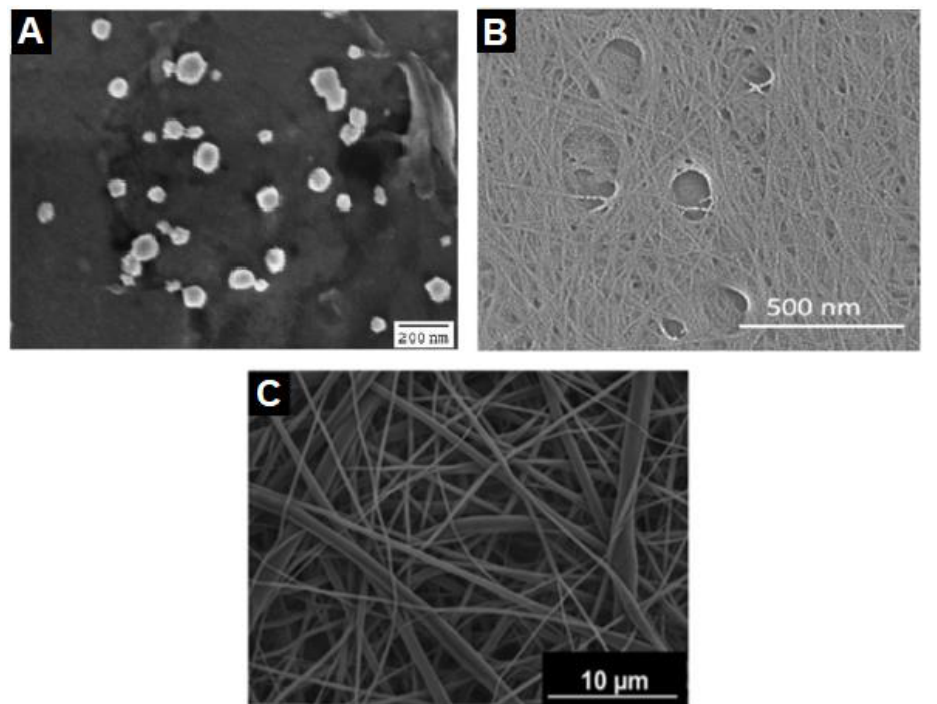
Figure 2. ( A ) SEM image of amorphous nanocellulose. Reproduced with permission from [54], [Carbohydrate Polymers]; published by [Elsevier, 2007]. ( B ) SEM image of cellulose nanoplatelets. Reproduced with permission from [55], [Carbohydrate Polymers]; published by [Elsevier, 2018]. ( C ) Top-down SEM image of electrospun cellulose nanofiber. Reproduced with permission from [57], [Carbohydrate Polymers]; published by [Elsevier, 2019]. Researchers have been encouraged to implement the use of nanocellulose for non- toxic applications due to its extensive physical, chemical, and biological properties. Due to their nanosize, they possess unique characteristics, including high mechanical strength, high surface area, surface chemical reactivity, barrier properties, renewability, biodegra- dability, biocompatibility, and non-toxicity [58,59]. As nanocellulose is known as a bio- based polymeric material equipped with unique properties and biocompatibility and re- newability, it can be used in a variety of ways in many eco-friendly fields, especially in the food, cosmetics, and pharmaceutical industries. In the food industry, it has been used as food additives and in food packaging materials [60]. In addition to this, its low cytotox- icity and high biocompatibility have attracted much attention in the biomedical field, where it has been employed in health care applications [46]. Due to its nano-size, it is also able to act as an effective drug carrier that can penetrate through skin pores either for medicine or cosmetic uses [61, 62]. As nanocellulose bears many hydroxyl groups on its surface, it tends to aggregate in non-polar solvents, which limits its application and use. To overcome this problem, it must undergo surface modification to alter its hydrophilicity characteristic through chem- ical, physical, or even biological interactions [41]. There are numerous approaches to nanocellulose functionalization such esterification, etherification, silylation, grafting of polymers, and others [45,63,64]. Figure 3displays a few common surface modifications of nanocellulose via chemical, physical, and biological approaches. The modification of nanocellulose results in a wide range of wettability in the water – oil phases while remaining insoluble in either phase. This results in the bio-based nano- materials irreversibly adsorbing on the water – oil interfaces, and encapsulation of the